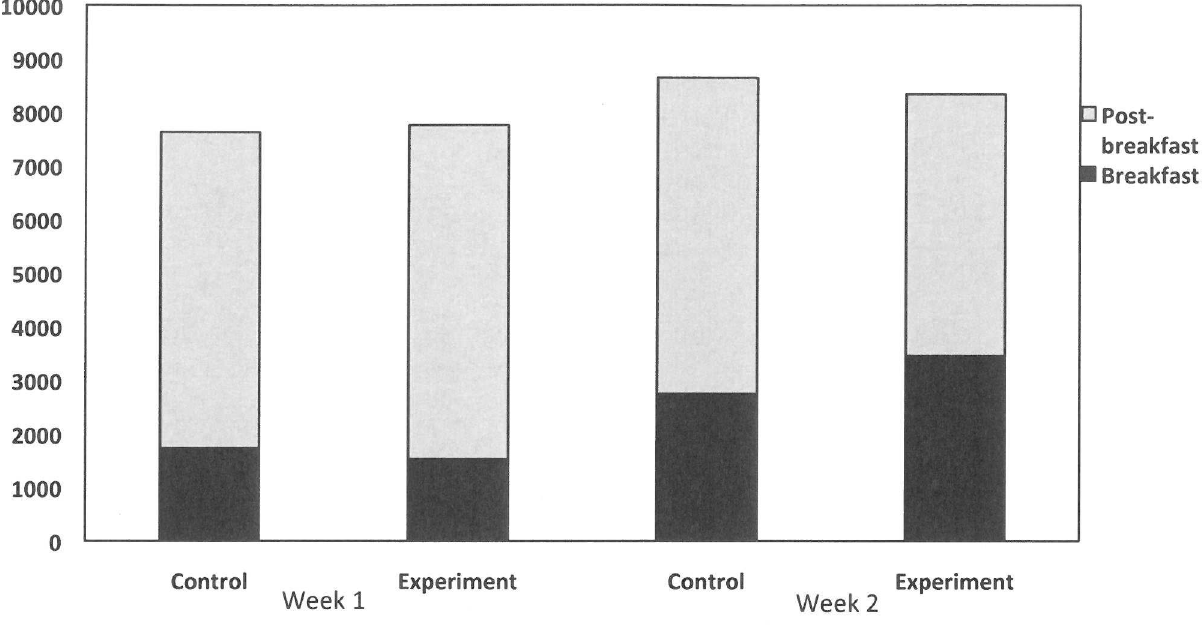
Fig 5. Food diary data. An illustrationof the compensation of energy intake across weeks and betweengroups, followingthe breakfast manipulation.Overall energyintake is greater in Week 2 relativeto Week 1, with no differences betweengroups(i.e., caloric